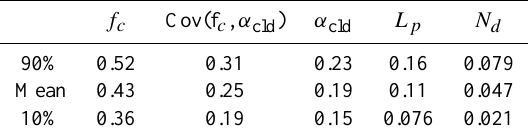
Table 1. Fractional contributions to albedo spatial variance (2000– 2008 time series). The mean, and the 90th and 10th percentiles of the distribution of daily contributions to spatial variance from each variable are shown. The L p and N d spatial variance contributions to albedo variance are computed by multiplying their contributions to τ spatial variance by the contribution of α cld to albedo spatial